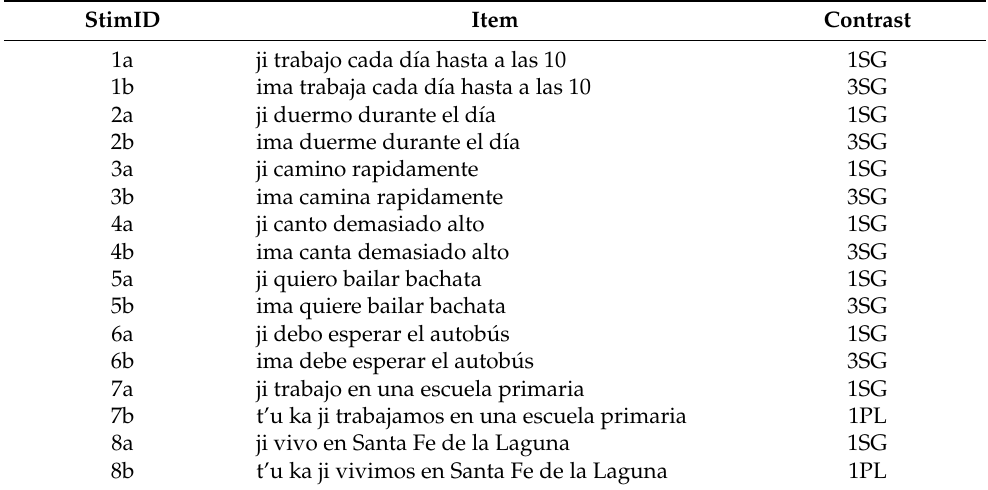
Table A2. Experimental stimuli: P’urhepecha to Spanish switches. Note that the translations are the same as for the target items presented in the table